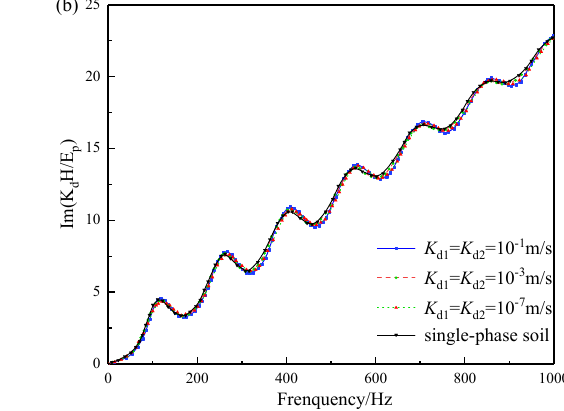
Figure 3. Influence of fluid viscosity and permeability of soil on pile impedance (reproduced from Zeng and Rajapakse (1999) [36]).